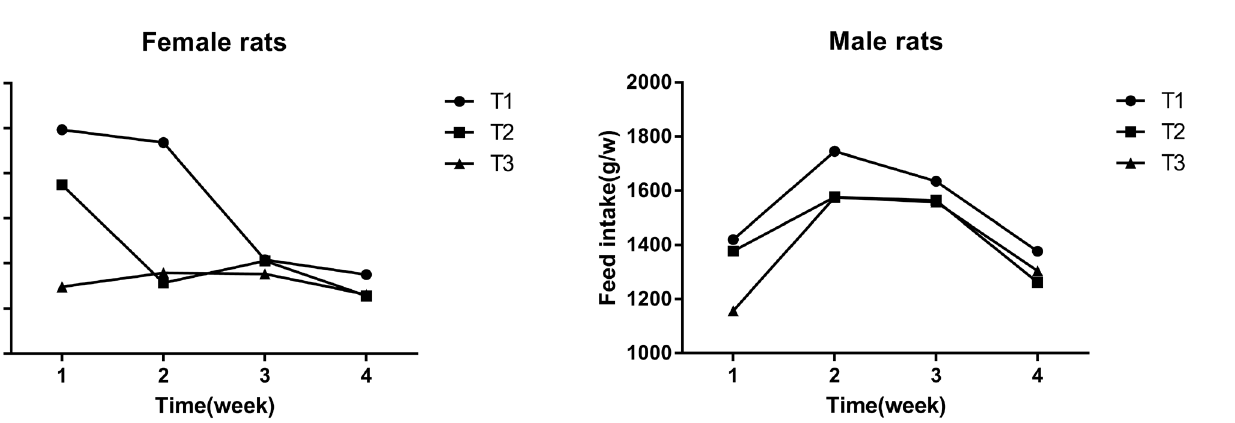
Figure 4. Effect of mulberry leaves on feed intake of Male rats. The x- and y-axes indicate time and feed intake, respectively. T1 = control group, T2 = low dose group, T3 = high dose